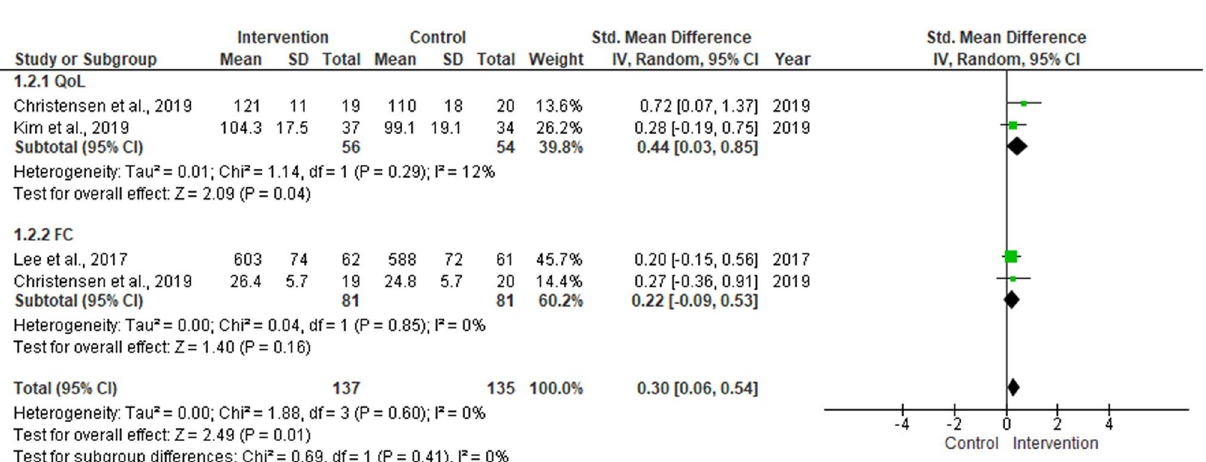
Figure 2. Meta-analysis of quality of life (QoL) and functional capacity (FC) measured in randomized controlled trials that conducted home-based exercise intervention for colorectal cancer patients.